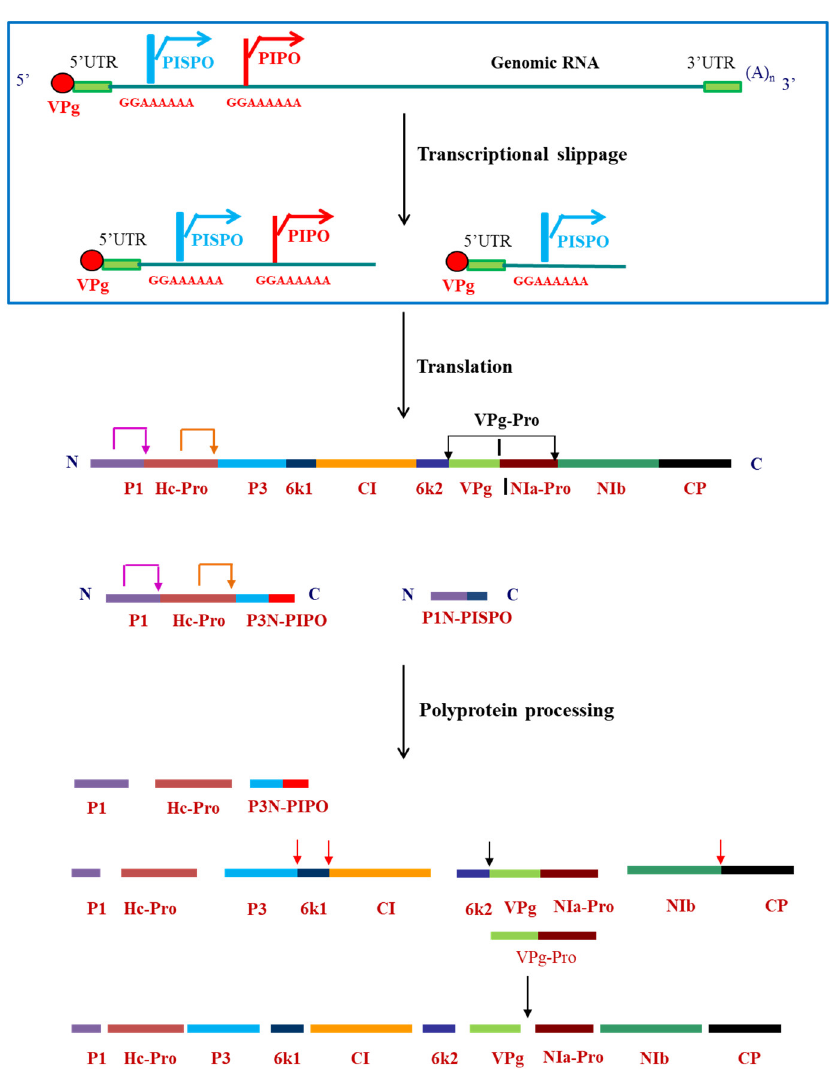
Figure 1. Genome organization of viruses belonging to Potyvirus genus, indicating the transcriptional slippage at the slippery sequences and polyprotein processing by the viral-encoded proteases to form mature proteins. Pink arrow at the P1 and orange arrow at the HC-Pro cleavage sites indicate self-cleavage of the two proteases. Red arrows indicate trans cleavage by VPg-Pro and black arrows indicate the cis cleavage by VPg-Pro.